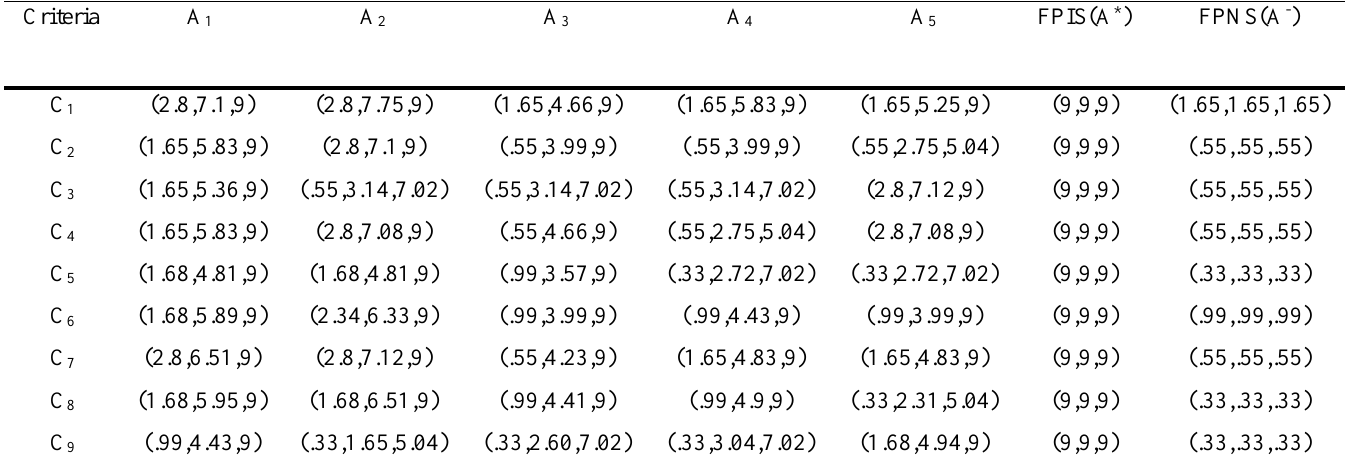
Table 8. Weighted normalized alternatives, FPIS and